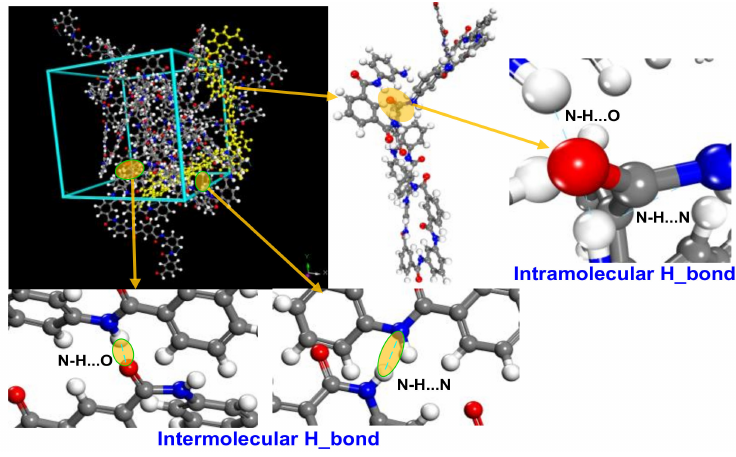
Figure 12. Hydrogen bonding network formed in an amorphous area of a meta-aramid